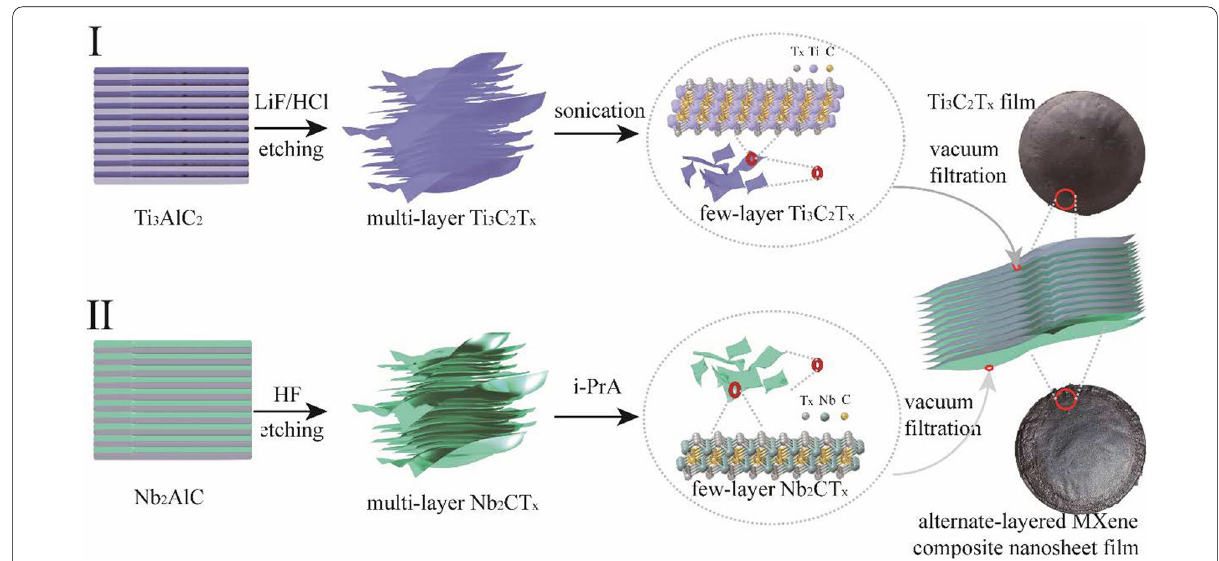
Fig. 1 Schematic illustration of the fabrication process of alternate-layered MXene composite nanosheet